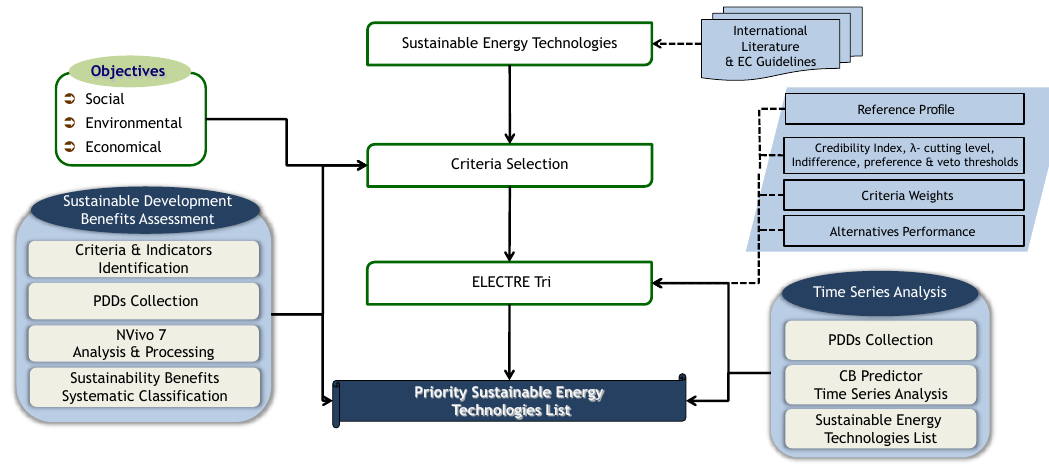
Figure 4. 2nd component—identify. Table 1. The alternative sustainable energy technologies [7,45–52]. SC: supercritical; PC: pulverised coal; CMM: coal mine methane; CHP: combined heat and power; IGCC: integrated gasification